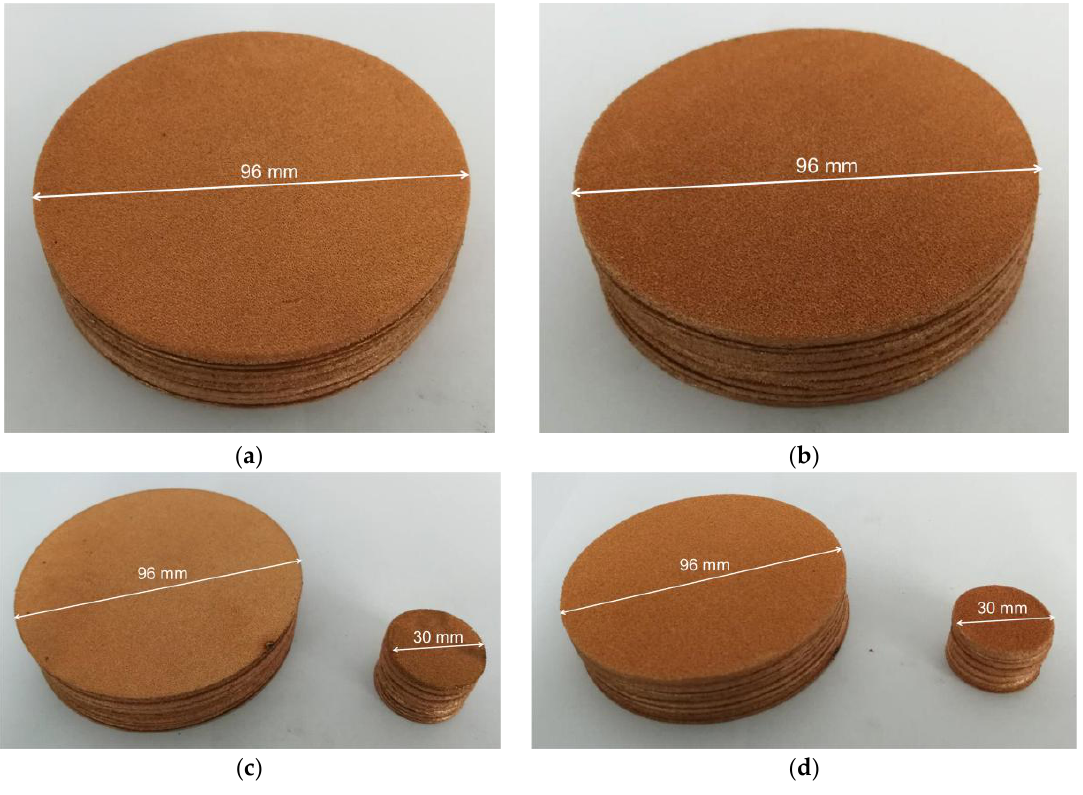
Figure 6. The prepared 10-layer gradient compressed porous metals for the varied frequency ranges.